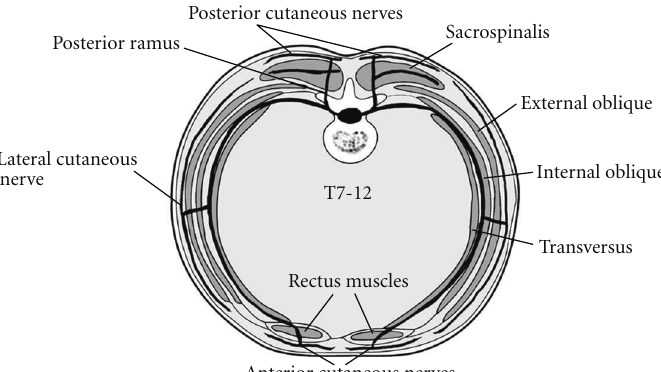
Figure 2: Transverse section of the abdominal wall demonstrating the relevant muscular structures and course of nerves (T7-T12) within the TAP [9]. Reproduced with permission.